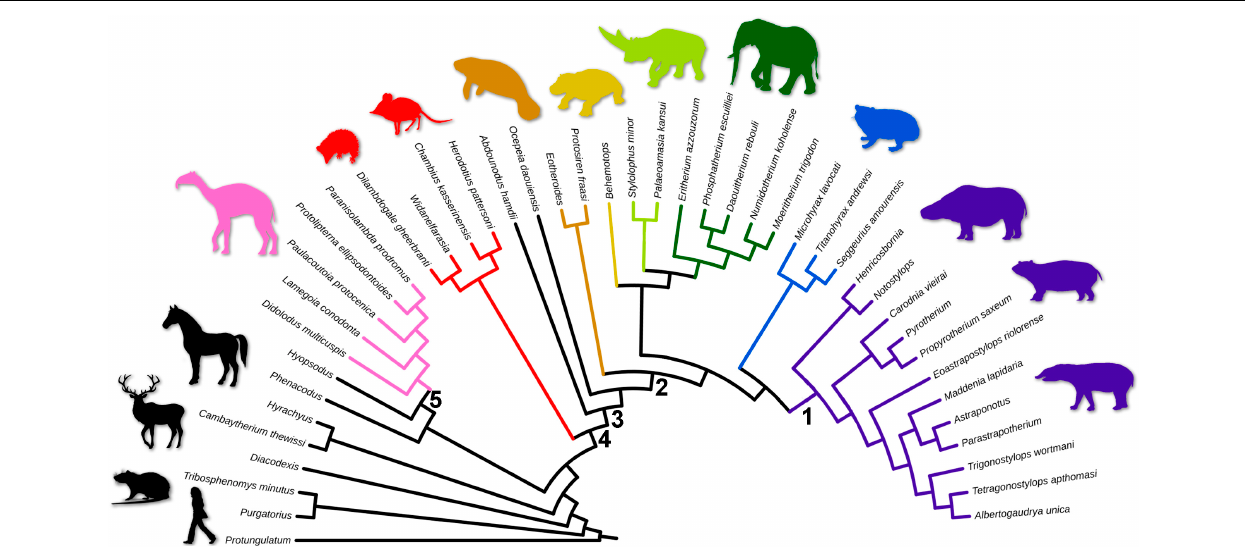
FIGURE 1 | Phylogeny of Sudamericungulata within Eutheria, the single phylogenetic tree using the algorithm “New Technology search” with implied weighting. Colored clades are as follows: Sudamericungulata (purple), Hyracoidea (blue), Proboscidea (dark green), Embrithopoda (light green), Desmostylia (yellow), Sirenia (orange), Afroinsectivora (red), and Litopterna + “Didolodontidae” (pink). Numbered clades are as follows: (1). Sudamericungulata, (2). Paenungulata, (3). Paenungulatomorpha, (4). Afrotheria, and (5). Panameriungulata. The silhouettes of mammals are out of